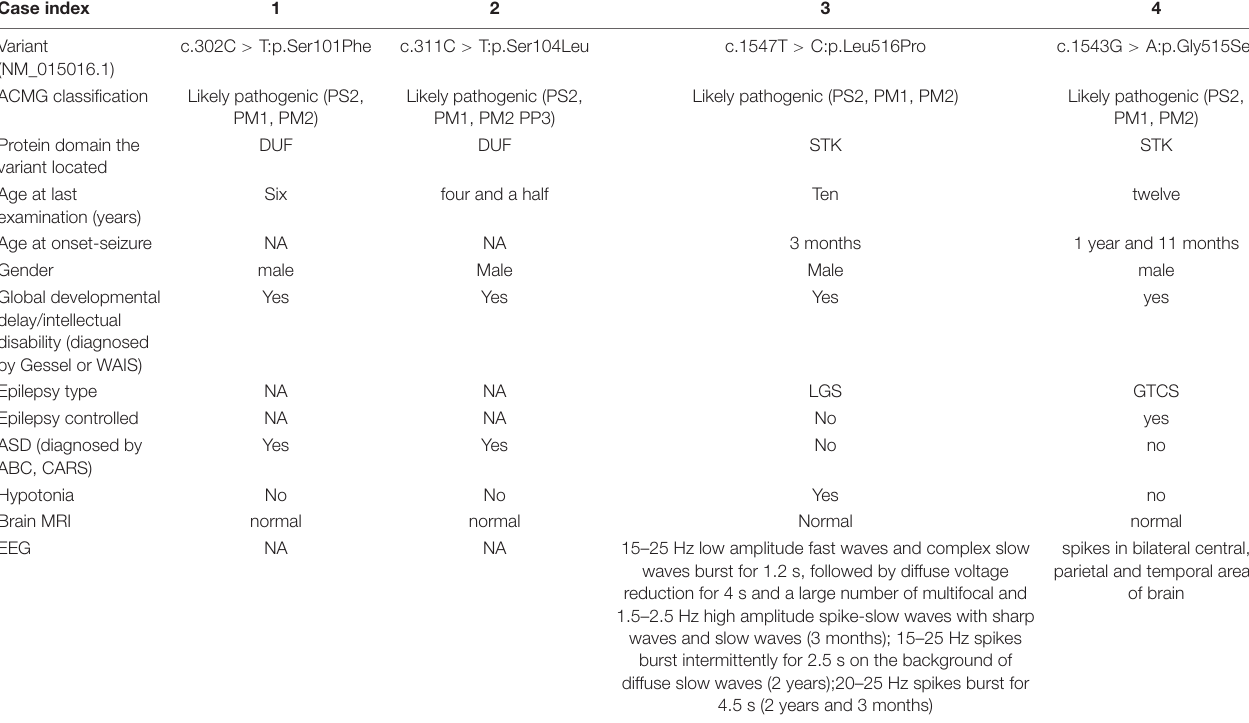
TABLE 1 | Summary of genotype and phenotype information for NDD in individuals with Microtubule associated serine/threonine kinase 3 variants. Case index 1 2